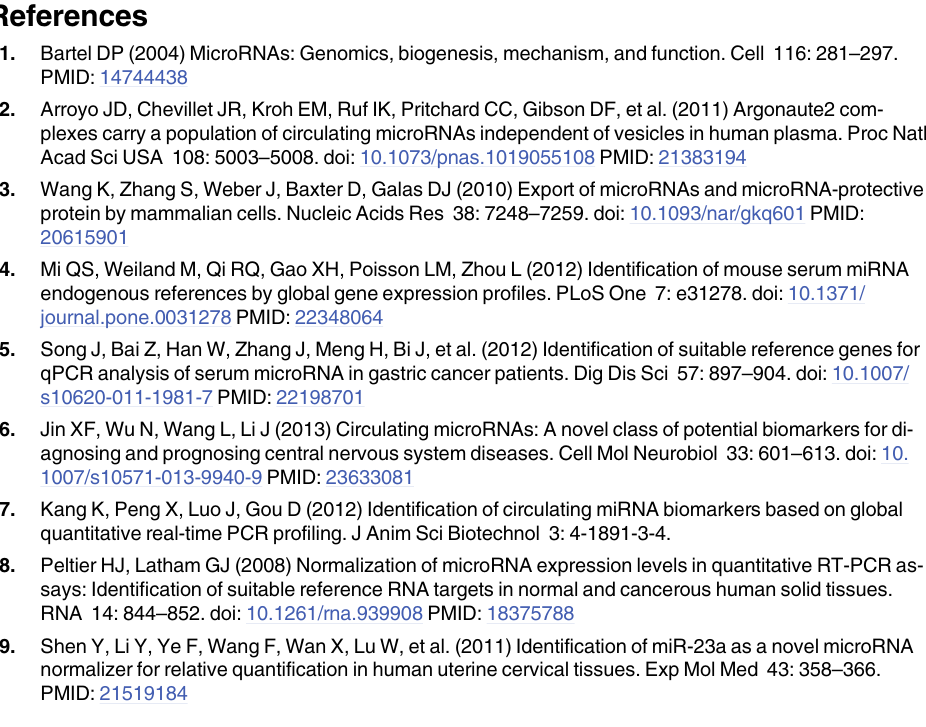
S1 Table. PCR efficiency of candidate reference miRNAs. S2 Table. Cq values of validated reference genes under different gender conditions. S3 Table. Cq values of validated reference genes when evaluated among different